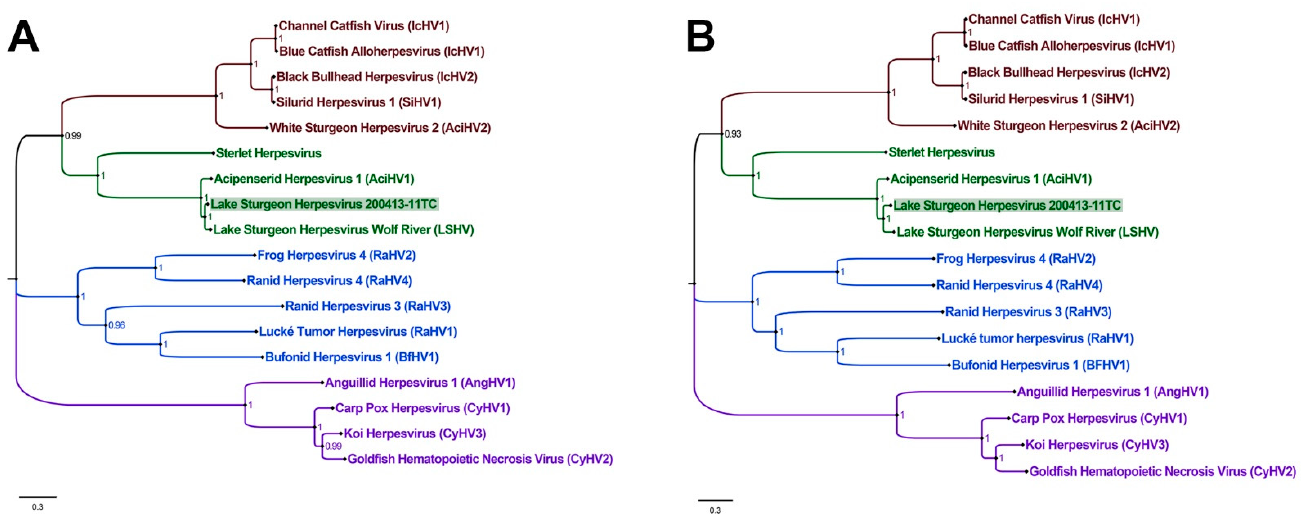
Figure 5. Dendrograms depicting the phylogenetic relationships between ( A ) translated and concatenated ter1 and pol genes from 17 alloherpesviruses; and ( B ) translated and concatenated 12 core genes from 17 alloherpesviruses. In both dendrograms, lake sturgeon herpesvirus isolate 200413-11TC (this study; shaded) is well-supported as most similar to, yet distinct from, lake sturgeon herpesvirus Wolf River (OK485036) and AciHV-1 from White Sturgeon (OK275729). Across a series of alignment lengths and identities, the lake sturgeon herpesvirus Wolf River strain and the genomically characterized herpesvirus isolate recovered in the current study (Lake sturgeon herpesvirus isolate 200413-11TC) averaged 84.02% ANI (SD: 2.8074%; range 81.21–89.08%; Table 5), which is consistent with heterogeneity observed when comparisons were limited to the subset of 12 core genes. Comparably, across the same series of parameters, channel catfish virus and blue catfish alloherpesvirus averaged 94.10% (SD 0.53; range 93.38–94.82%) (Table S4), while Cyprinid Herpesvirus 1 and Cyprinid Herpesvirus 3 were too divergent to make comparable analyses (Table S5). Table 5. Average nucleotide identity estimations for Wolf River Lake Sturgeon Alloherpesvirus 1 (LSHV1; OK485036) and the Michigan State Strain of putative Lake Sturgeon Alloherpesvirus 2 (LSHV2).